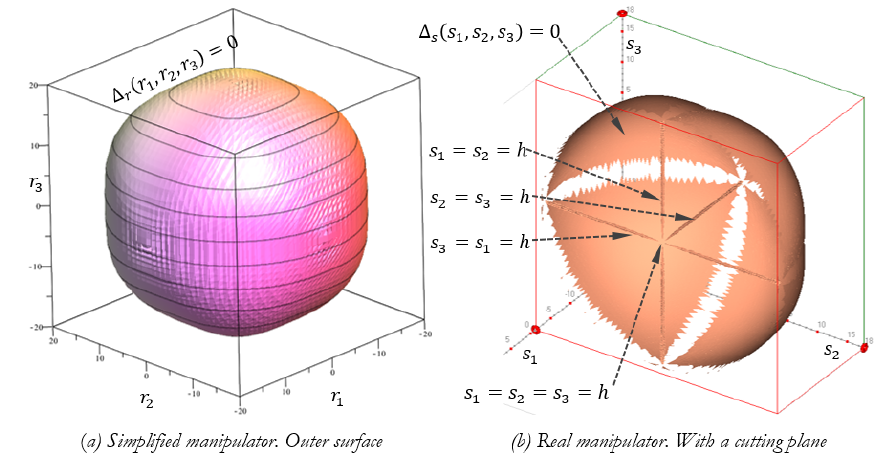
Figure 10. Direct singularity locus in the joint-space